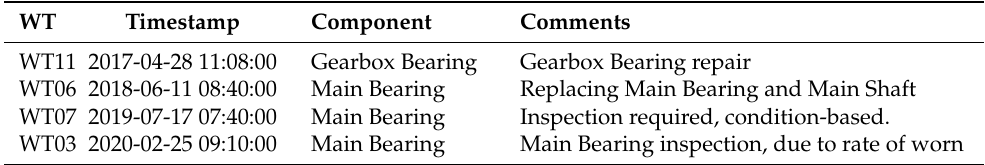
Table 2. Sample of work order